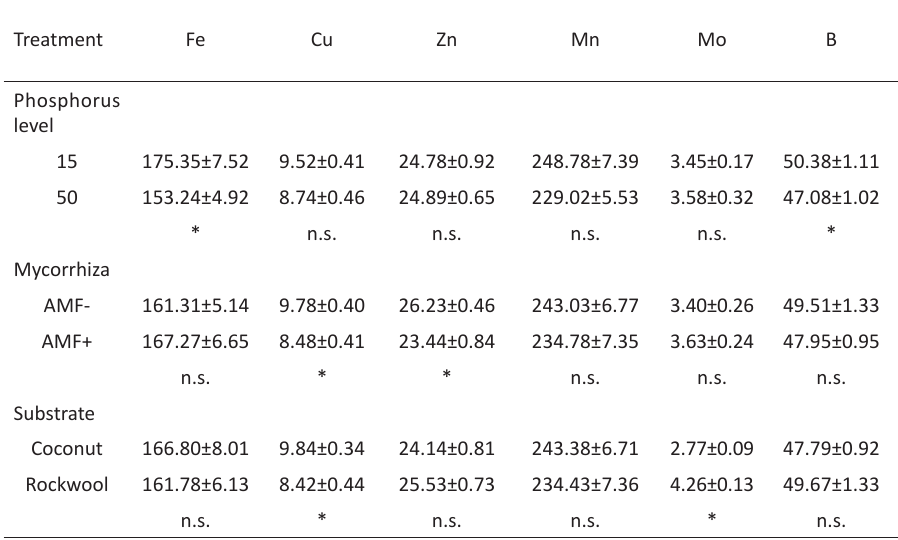
Table 6. Effect of phosphorus level in the nutrient solution (mg dm -3 ), mycorrhiza and type of substrate on microelements content in tomato leaves (mg kg -1 dry matter).